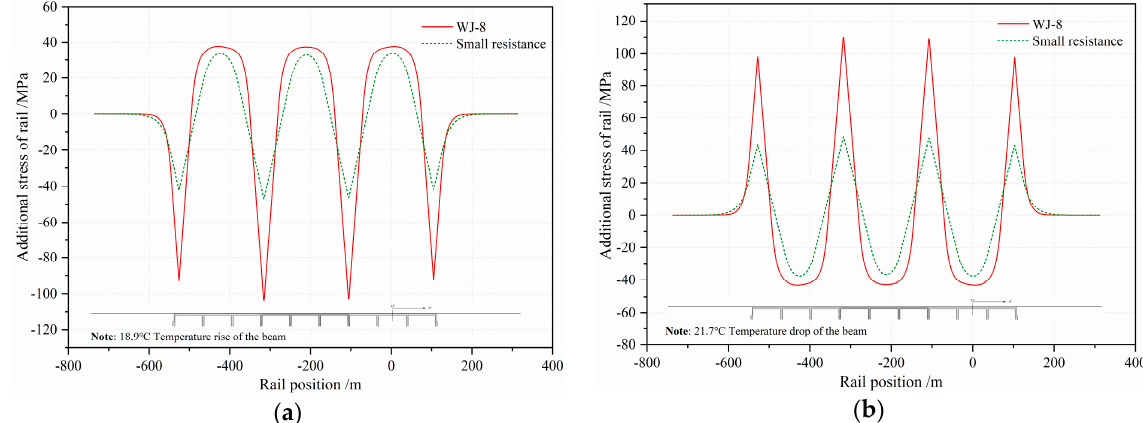
Figure 9. Additional expansion force of rails under bridge temperature variation: ( a ) temperature rising; ( b ) temperature dropping.